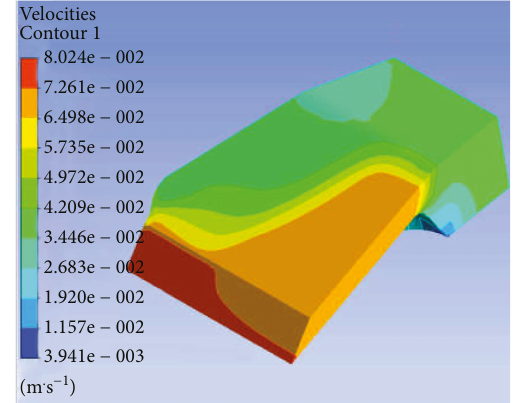
Figure 5: Velocity simulation contour in the head runner.